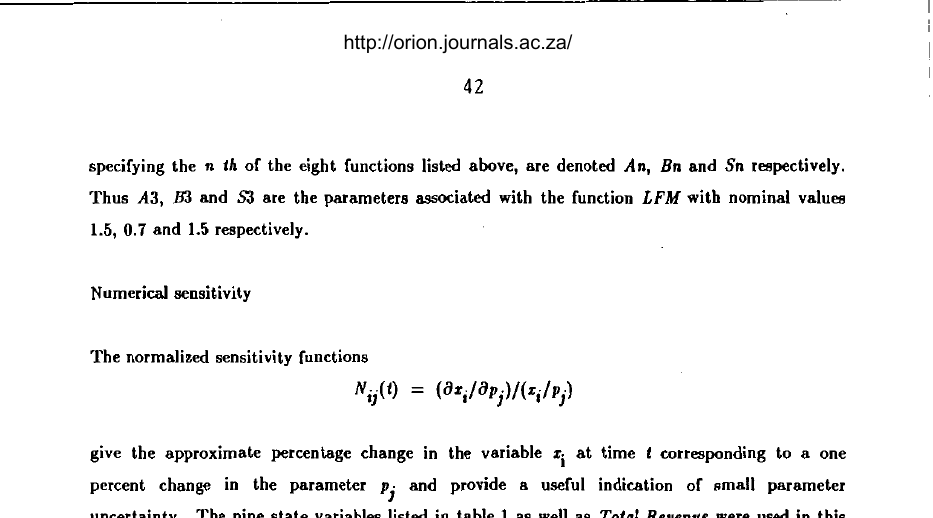
Maximum normalized sensitivity function